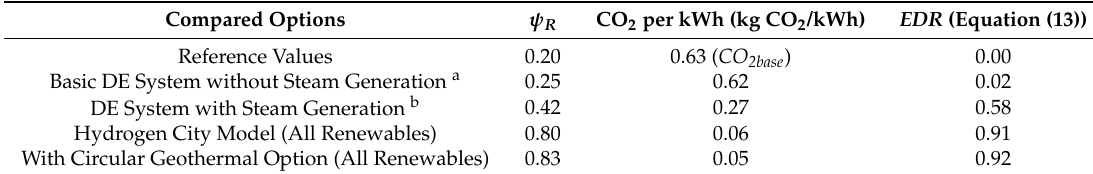
Table 4. Overall Comparison of Conventional and Proposed District Energy System Options. Compared Options ψ R CO 2 per kWh (kg CO 2